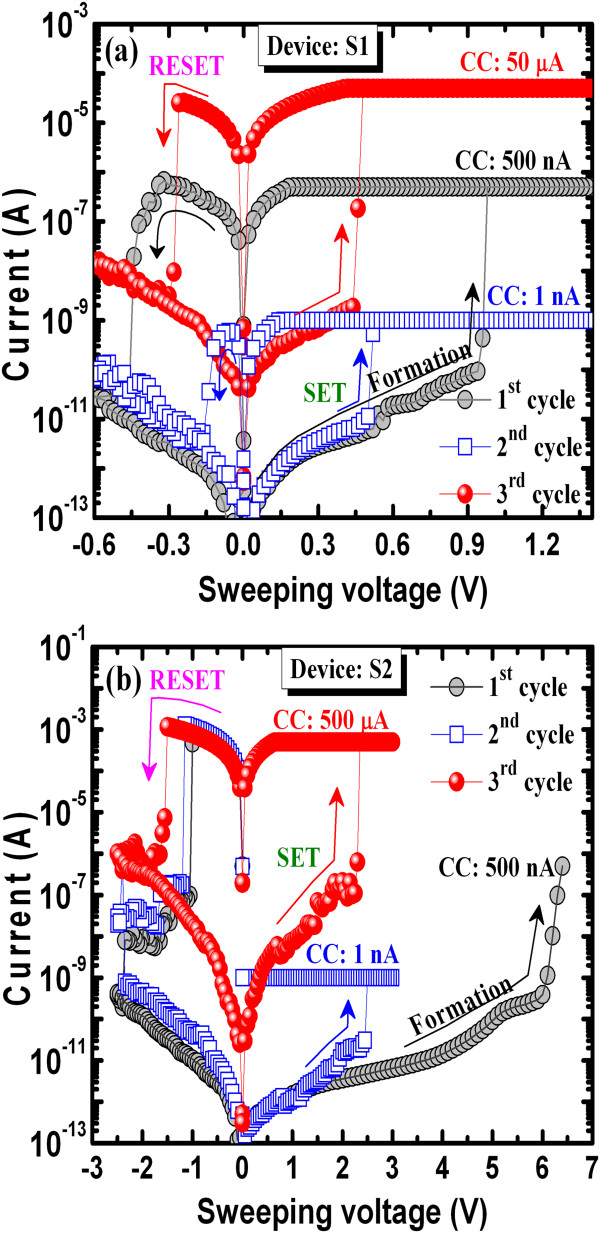
Bipolar resistive switching characteristics. (a) Typical I-V characteristics of Cu/GeOx/W and (b) Al/GeOx/W cross-point memories.